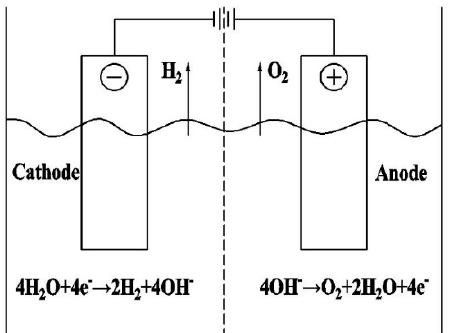
Figure 1. Schematic diagram of electrolysis of alkaline aqueous solution.